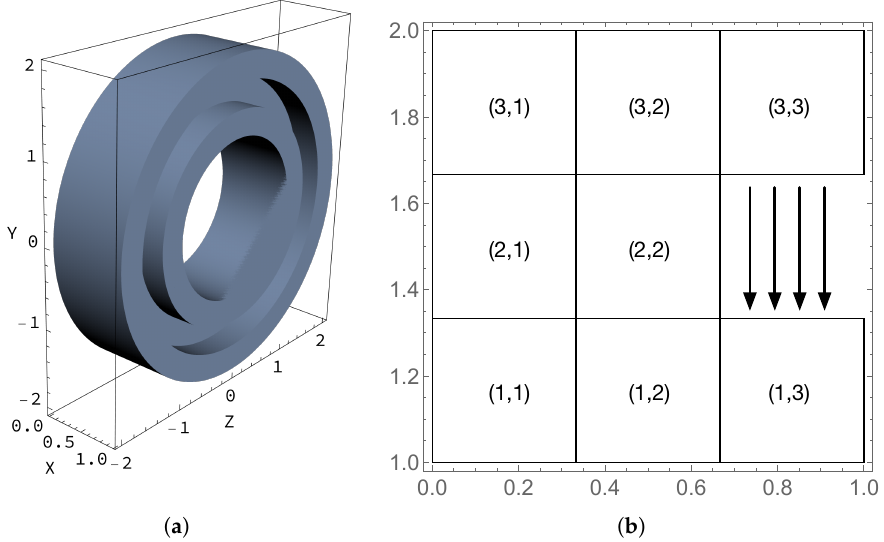
Figure 1. Model problem configuration. The computational domain has three layers and eight regions. The traction loading that acts on the inner boundary segment is indicated with arrows. The boundary at x = 0 is fully clamped, while all other boundaries are free. ( a ) CAD model of the domain; ( b ) computational